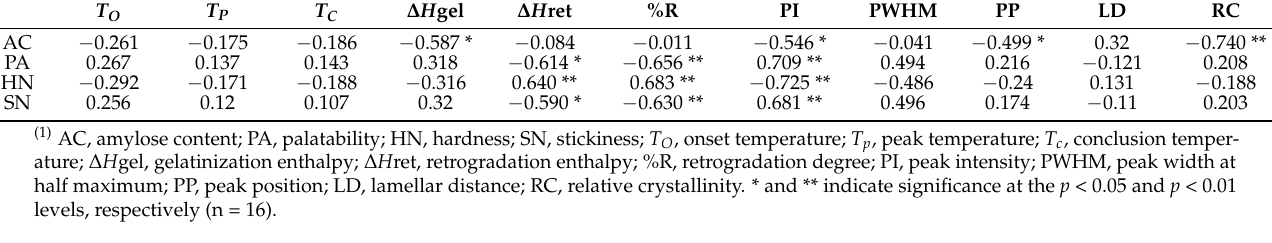
Table 8. Correlations between the eating quality, starch structure and gelatinization properties (1) of japonica rice cultivars. T O −